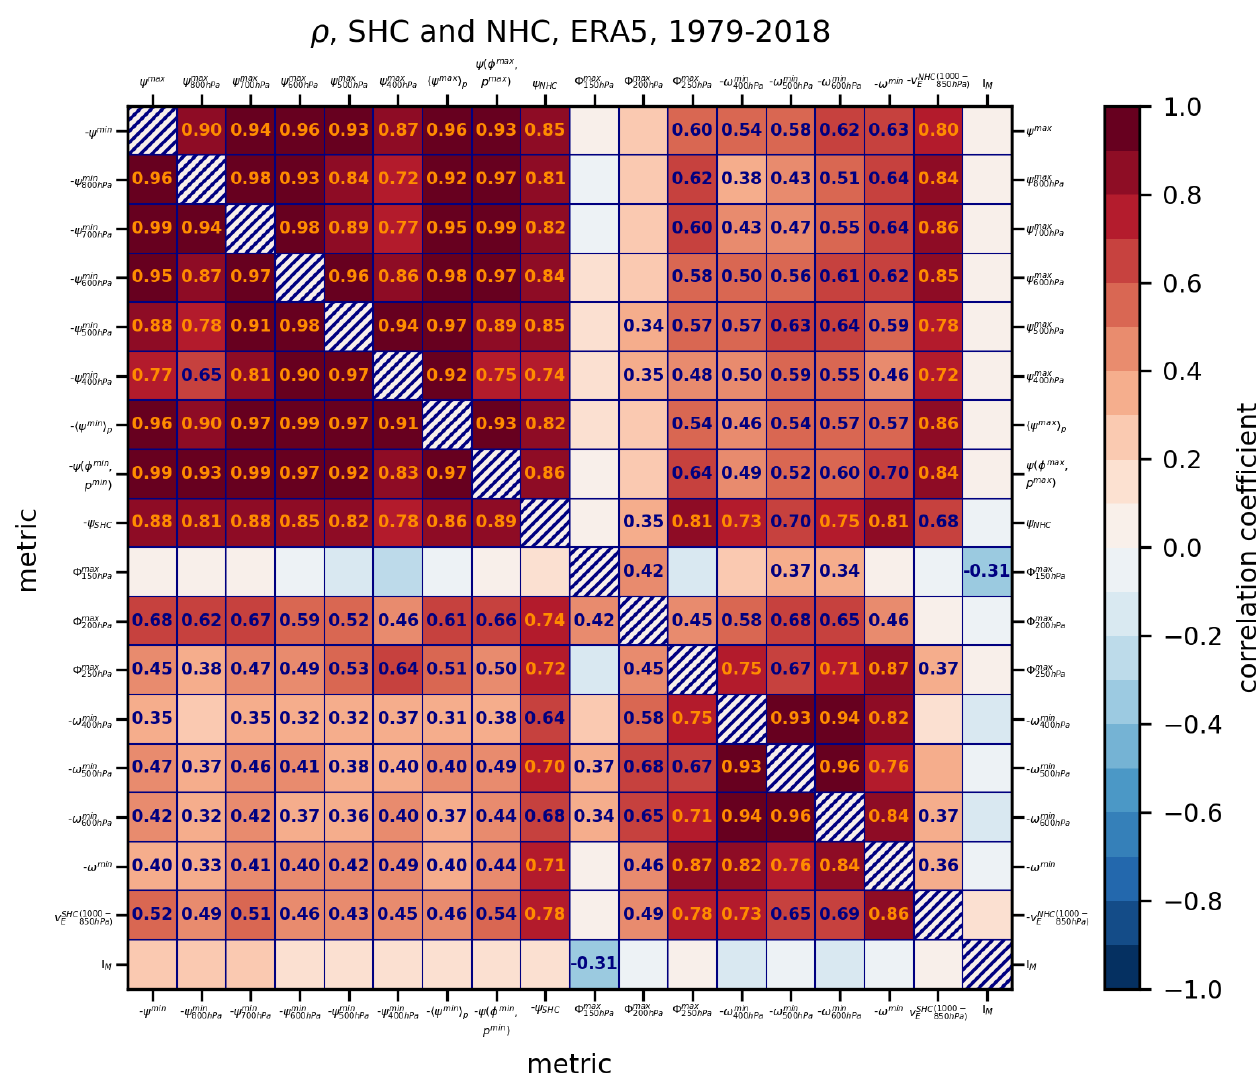
Figure 5. Correlations of time series, derived from different metrics of Hadley cell strength, described in Sect. 2.2, for the 1979–2018 period in ERA5 reanalysis. The correlations for the northern Hadley cell are shown in the upper right part of the matrix, whereas the southern Hadley cell correlations are represented in the lower left part. Time series of ω(p) min are multiplied by ( − 1 ) so that more positive values correspond to HC strengthening. Similarly, the time series of the stream-function metrics ψ min and time series of the effective wind for the lower tropospheric water vapour transport metric v NHC are also multiplied by ( − 1 ) so that more positive values correspond to HC strengthening. E Only correlations exceeding the 95% significance threshold are